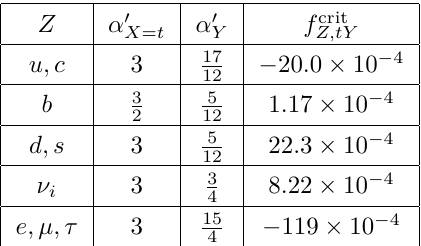
, α 0 , and f crit for the Yukawa coupling of fermion Z . X = t Y Z,tY